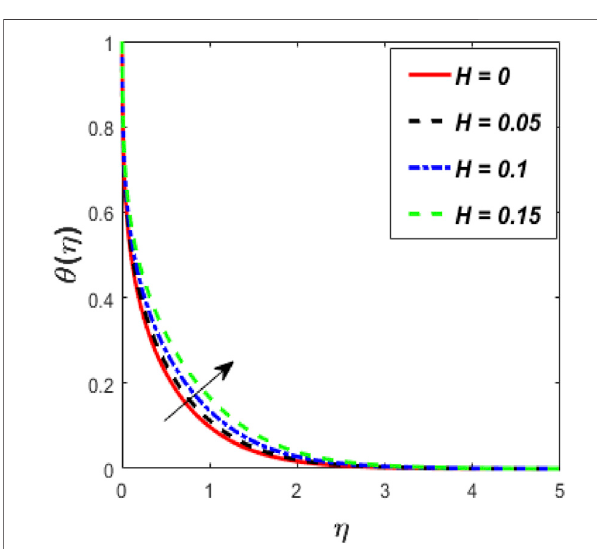
FIGURE 6 | H against θ ( η )